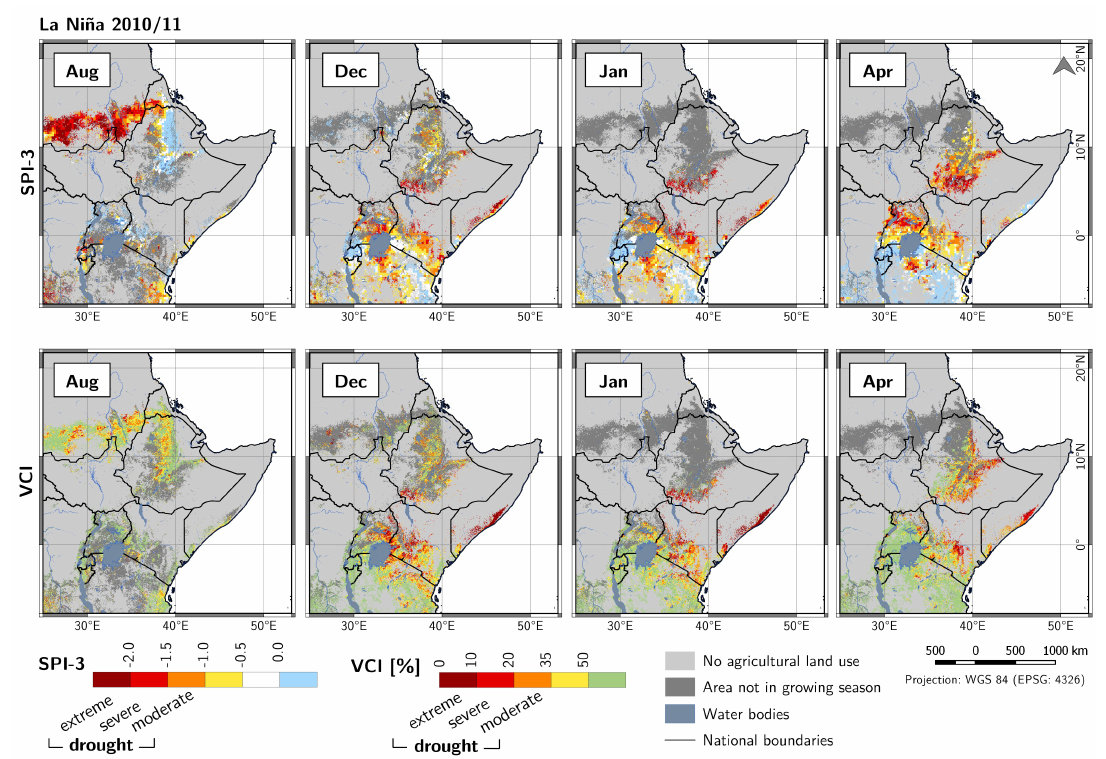
Figure 10. Drought dynamics based on SPI-3 and monthly means of VCI during La Niña event 2010/2011 (moderate) for August (Aug.), December (Dec.), January (Jan.) and April (Apr.) in East